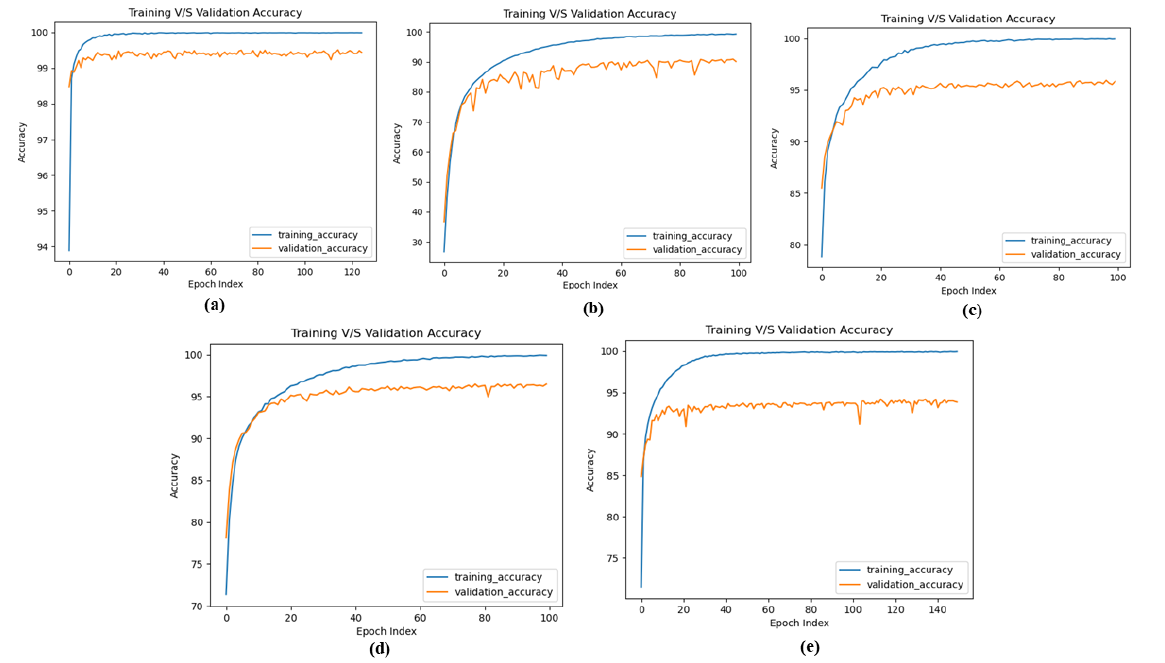
Figure 9. Training and Validation curves: ( a ) MNIST ( b ) CIFAR-10 ( c ) KITTI ( d ) Korean License Plate ( e ) SVHN.